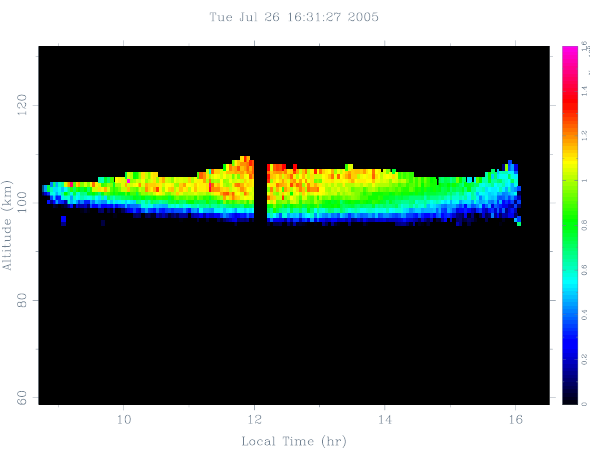
Fig. 2. E-region electron densities measured on 26 July 2005, using Faraday rotation. A black pixel implies no data.